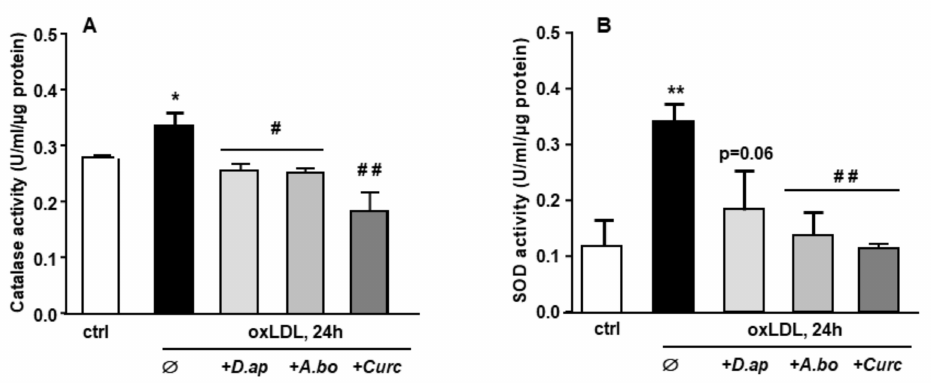
Figure 2. D. apetalum and A. borbonica extracts prevent oxLDL-induced cellular oxidative stress. Effects of polyphenol-rich extracts from D. Apetalum and A. borbonica or curcumin on antioxidant activity of oxLDL-stimulated HMEC-1 cells. Subconfluent serum-starved HMEC-1 cells were preincubated for 2 h with D. apetalum (25 µ M), A. borbonica (25 µ M) polyphenol-rich extracts or curcumin (10 µ M) before addition of oxLDLs (200 µ g apoB/mL) for an additional 12 h. ( A ) Catalase and ( B ) total SOD activities were expressed as catalytic units per µ g of proteins as means ± SEM of at least 3 independent experiments. * p < 0.05; ** p < 0.01 compared to control (ctrl, vehicle PBS); # p < 0.05; ## p < 0.01 compared to oxLDLs were calculated using one-way ANOVA with Tukey’s posthoc